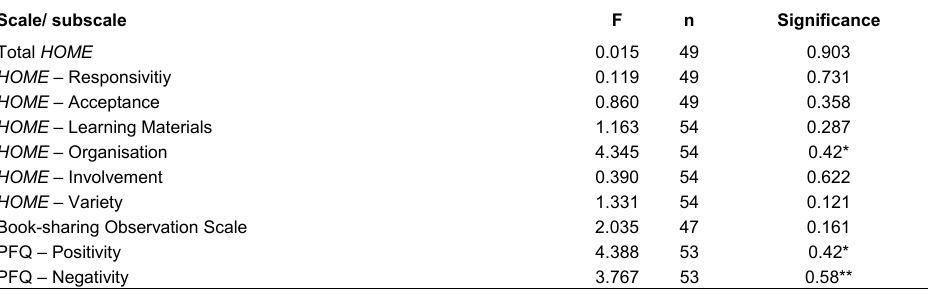
Changes in scores between early and late